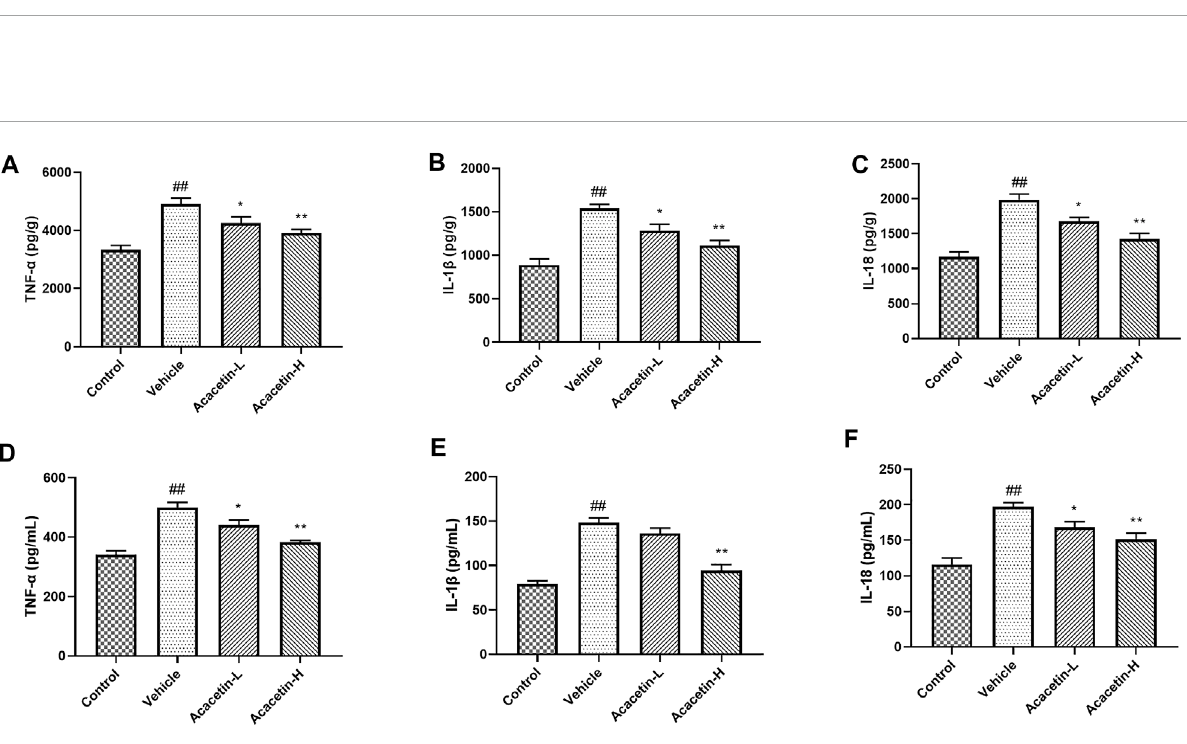
FIGURE 6 ELISA analyses of in fl ammatory factors in thehippocampusand tears. (A – C) Production ofTNF- α ,IL-1 β , andIL-18 inthehippocampus ofmice. (D – F) Concentrations of TNF- α , IL-1 β , and IL-18 in the tears of mice. Results are expressed as the mean ± SEM ( n = 6 per group). ## p < 0.01 vs. Control; * p < 0.05, ** p < 0.01 vs.